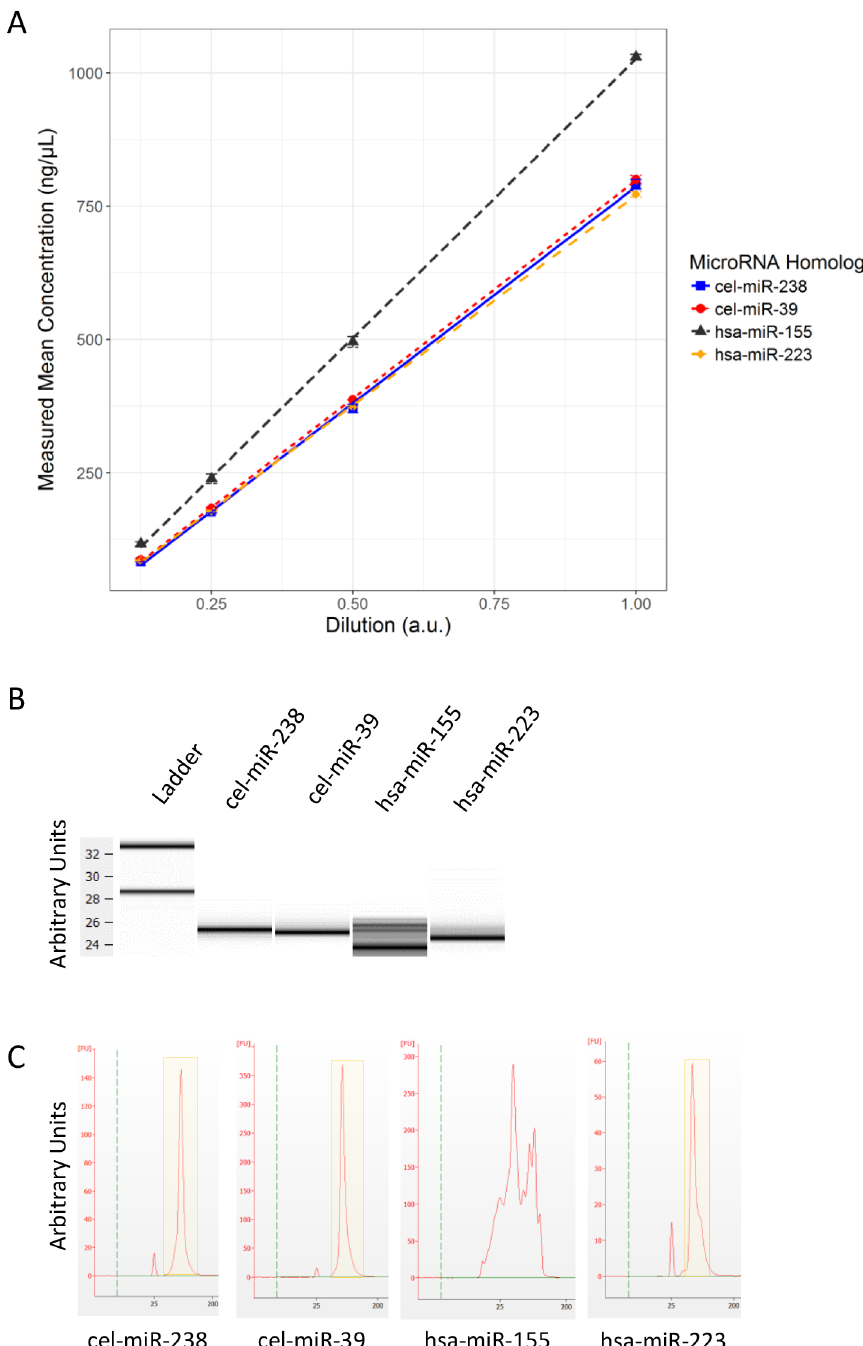
Fig 2. Analytical data for synthetic oligonucleotides. Manufacturer reportedthat synthetic oligonucleotides had a specificmolecularweightand dilutingthem as instructedwouldyield a concentration of 100 μ mol/L.A microvolume UV spectrophotometer was used to acquireabsorbance data for four syntheticoligonucleotides and (A) graphedas mean measuredconcentrationversus manufacturer intendedconcentration. Data from the chip-based automated electrophoresis system is shown as (B) electronicgel or (C) individualspectraldata. Yellowbox on electropherograms represents observedindividualpeakscorresponding to synthetic miRNA oligonucleotides. Graph (A) was developed usingggplot2in RStudio. Imagines(B) and (C) are directly from 2100Expert Software (AgilentTechnologies;Santa Clara, CA).